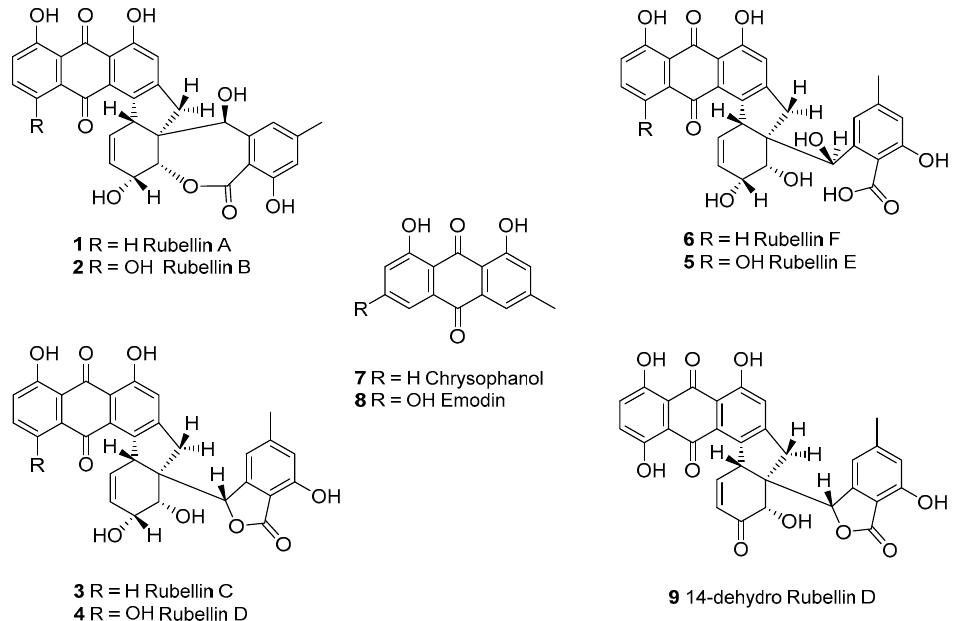
Figure 1. Structures of the rubellins A–F ( 1 – 6 ), chrysophanol 7 , the possible precursor of the